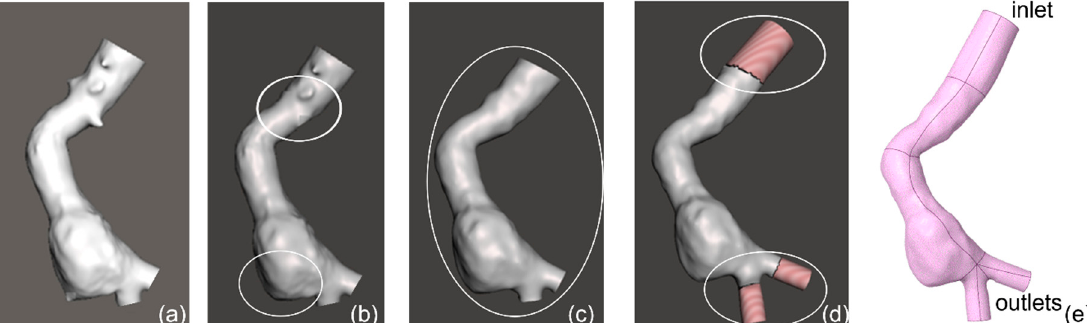
Figure 1. Main steps of the patient-specific aneurysm reconstruction from the Angio-CT medical images of a ruptured aneurysm: ( a ) rough segmentation (ITK_SNAP), ( b ) virtual repair and cut of minor arteries (Meshmixer), ( c ) global smooth (VMTK) ( d ) insertion of extensions (VMTK), ( e ) surface extraction (SpaceClaim).